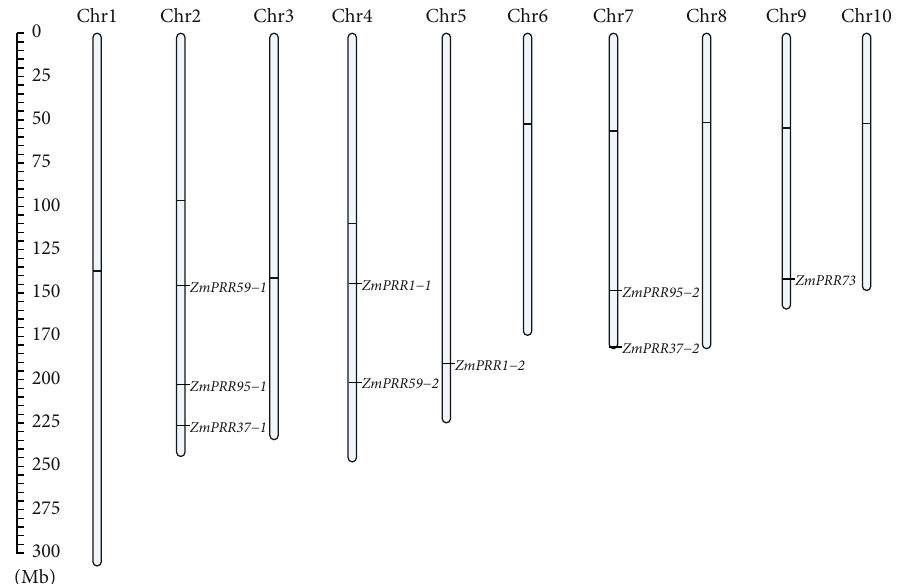
Figure 1: Chromosome distribution of PRR family genes in maize chromosomes. A total of 9 ZmPRR genes were mapped on the ten maize chromosomes with an uneven distribution. The chromosome numbers are indicated at the top of each bar. The gene names on the right side of each chromosome correspond to the approximate locations of each ZmPRR genes. The scale on the left is in megabases.